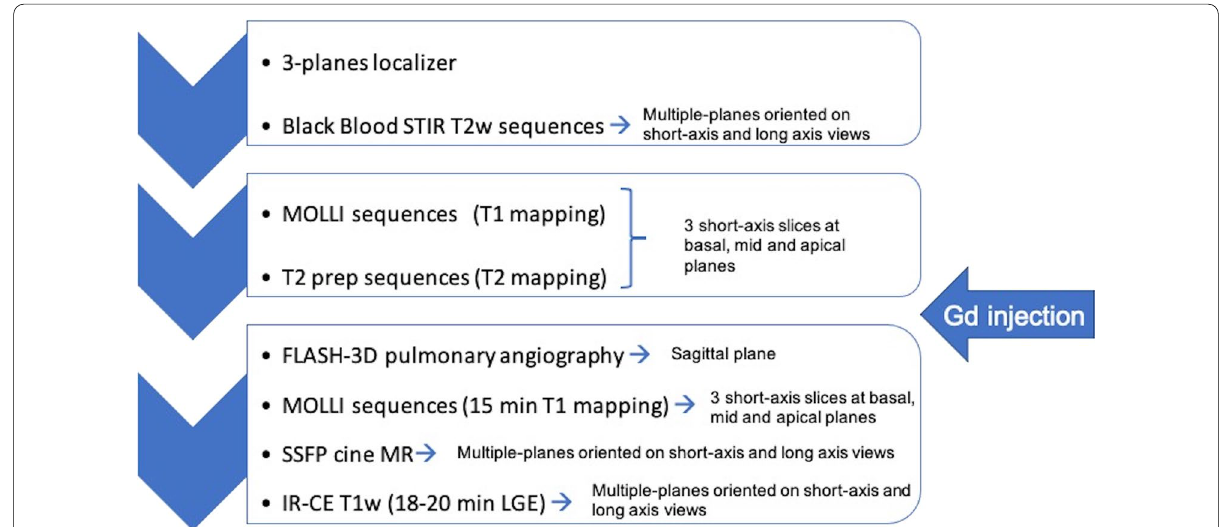
Fig. 3 Suggested CMR protocol for myocarditis diagnosis in COVID-19 patients. STIR short tau inversion recovery; MOLLI modified look-locker imaging; FLASH-3D fast low angle shot three-dimensional; SSFP steady-state free precession; MR magnetic resonance; IR-CE inversion recovery contrast enhanced; LGE late gadolinium enhancement; Gd